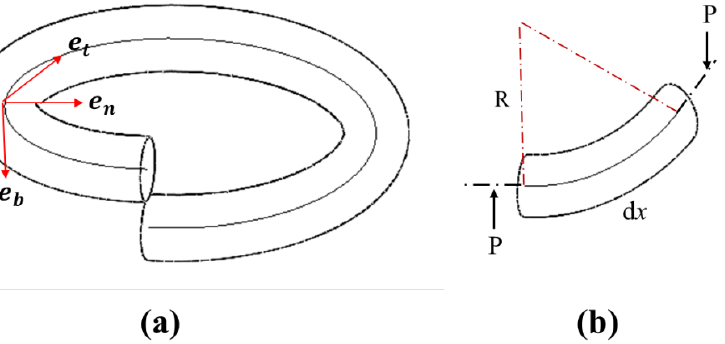
Figure 1. ( a ) One spring coil in the Serret-Frenet coordinates. ( b ) Unit rod element of a spring coil. Timoshenko beam theory therefore relates the forces and moments of the displace- ments and rotations of the unit rod elements, which allows calculations of the overall spring force according to the applied compression loads. Unlike Euler–Bernoulli beam theory,